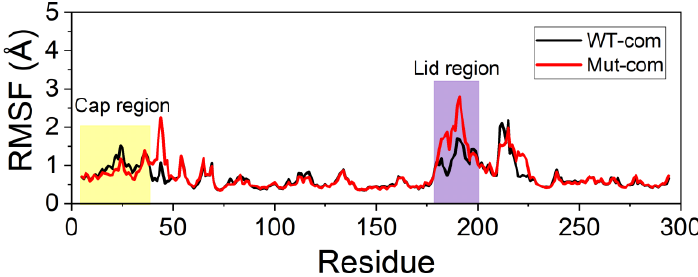
Figure 9. Cα RMSFs based on the last 100 -ns distance-limited MD trajectories. Table 1. Terms of the binding free energy between WT-com and Mut-com averaged over the last 20 ns of the replicate runs (kcal/mol).